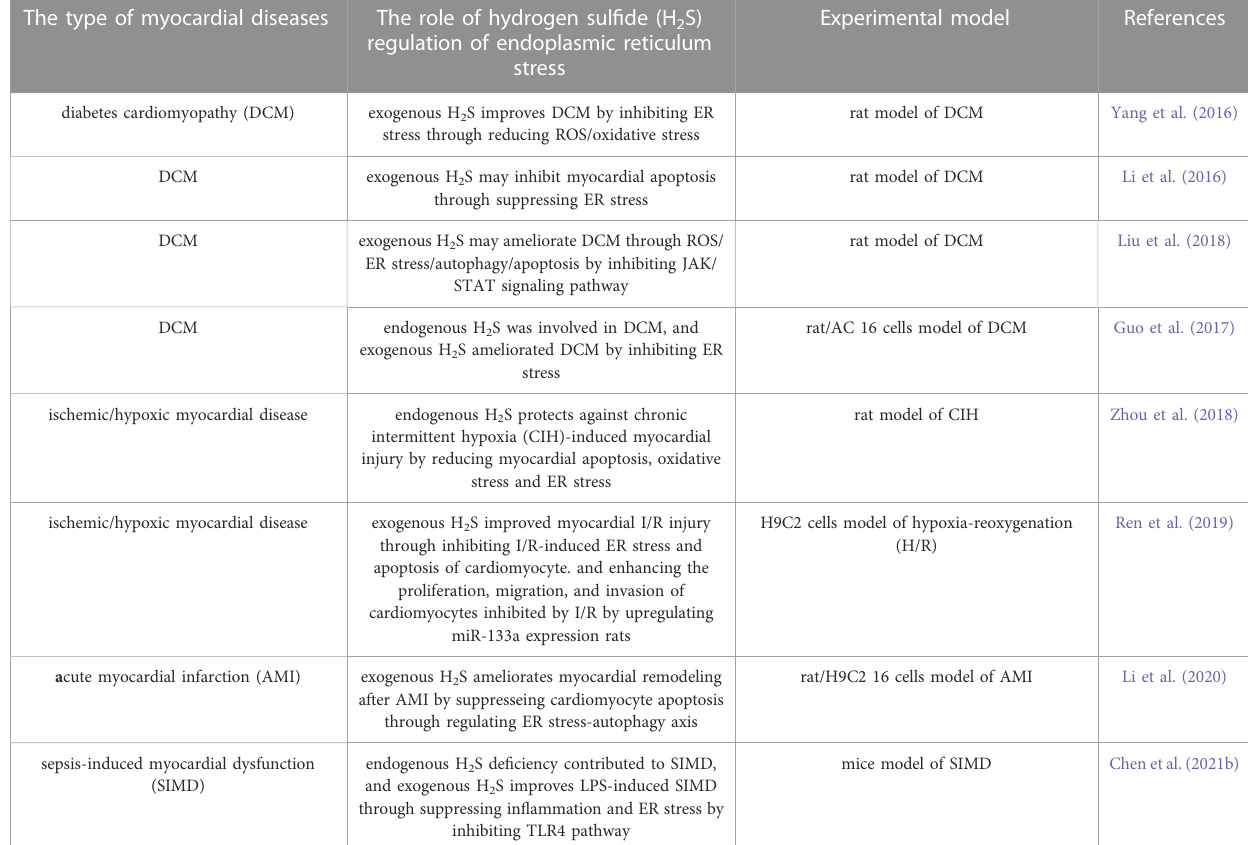
TABLE 1 The role of hydrogen sul fi de (H 2 S) regulation of endoplasmic reticulum stress in myocardial diseases. The type of myocardial